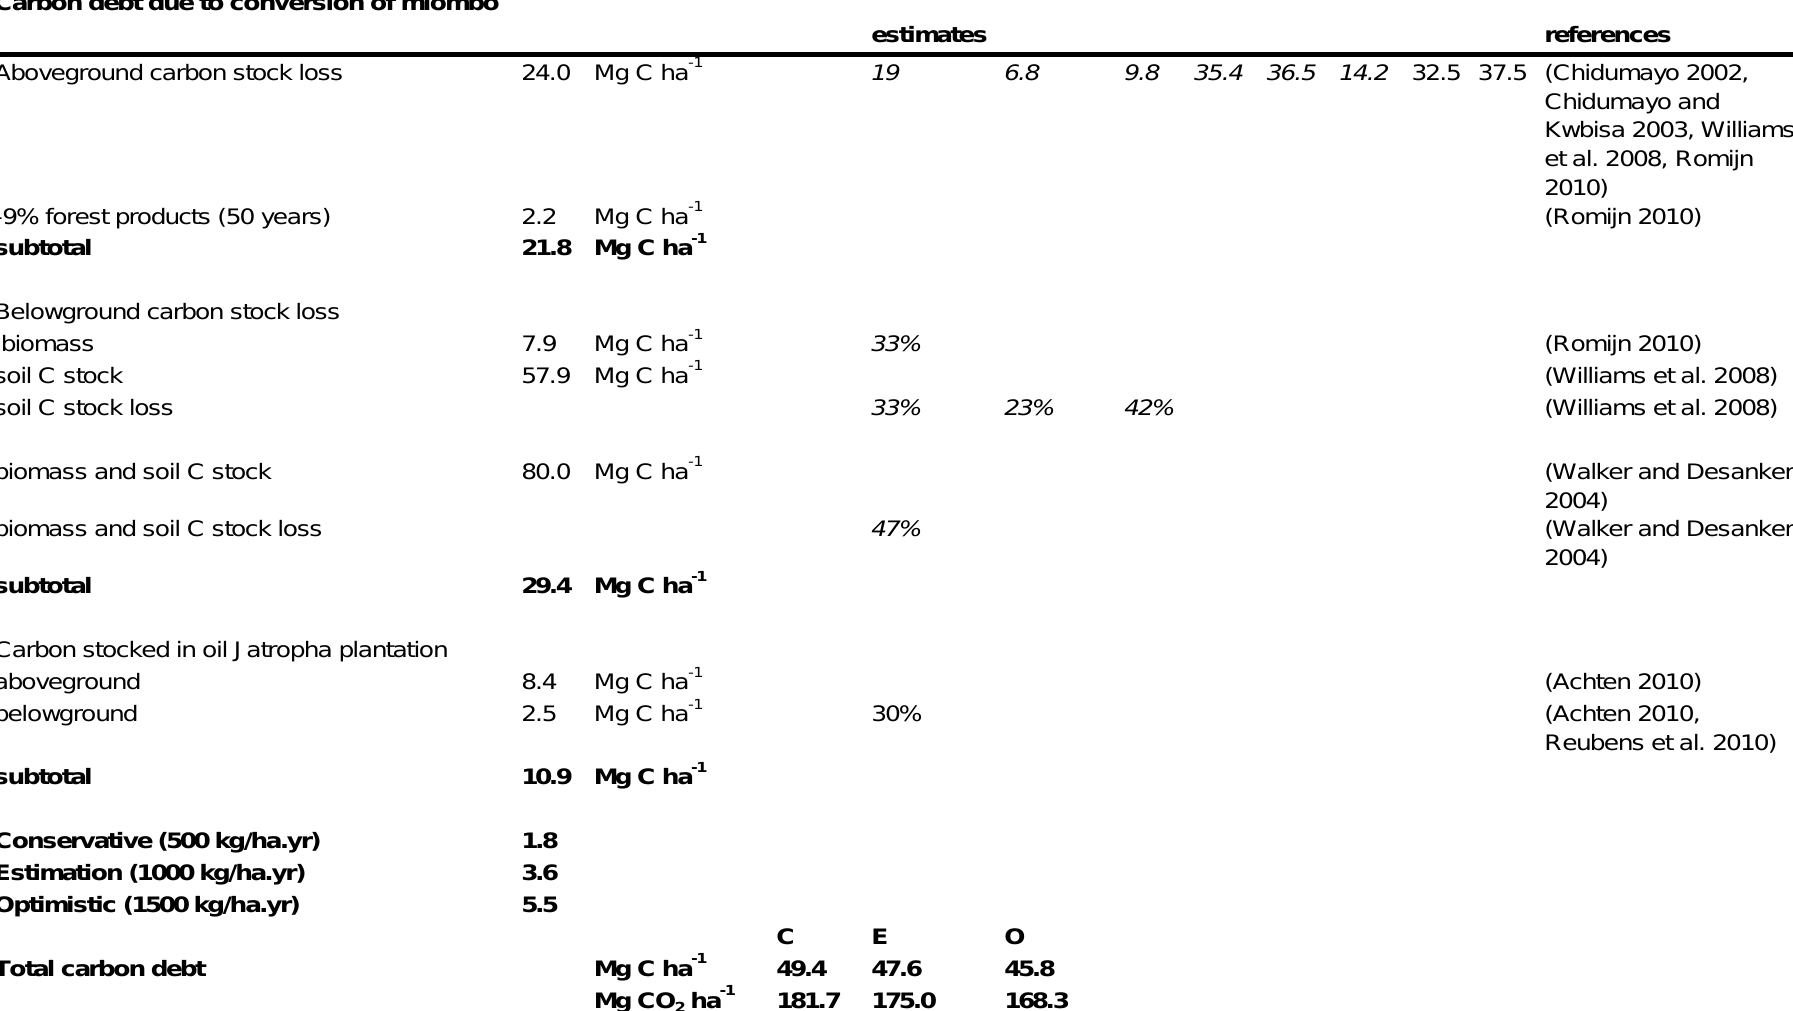
Table A5.1. Carbon debt calculation of Zambia